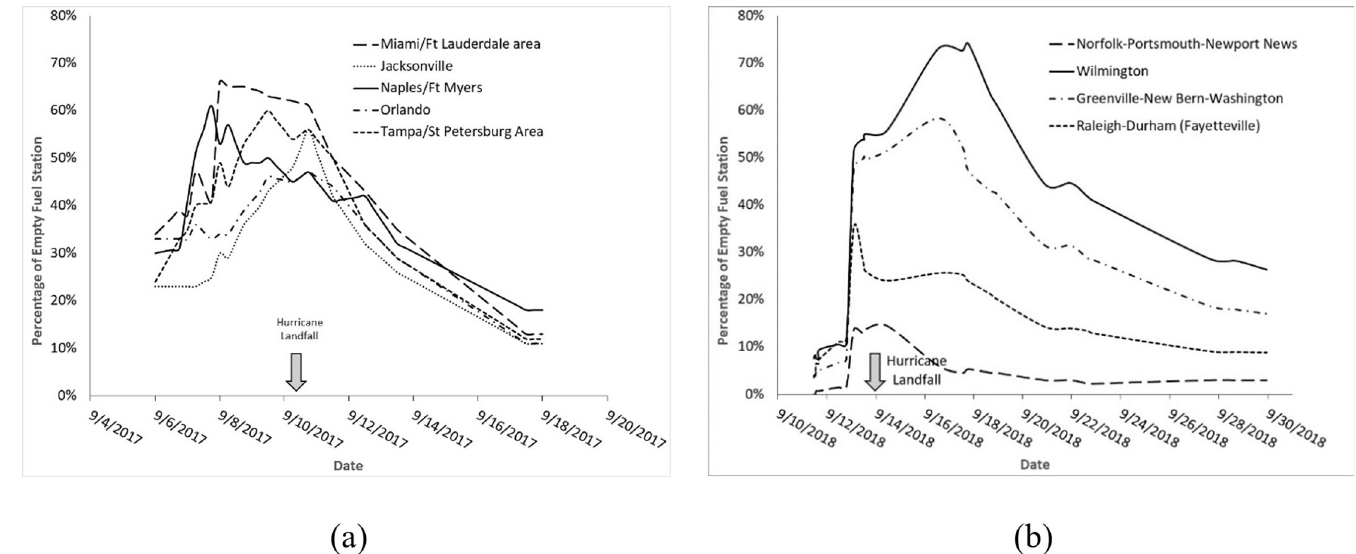
Fig 2. (a) The fuel shortage data from 2017 Hurricane Irma, (b) Similar data for 2018 Hurricane Florence.